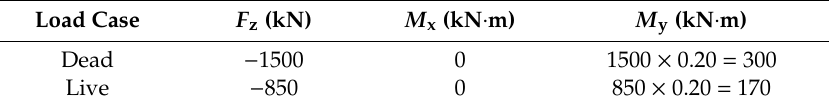
Table 5. Example 1: Reaction forces in the column.